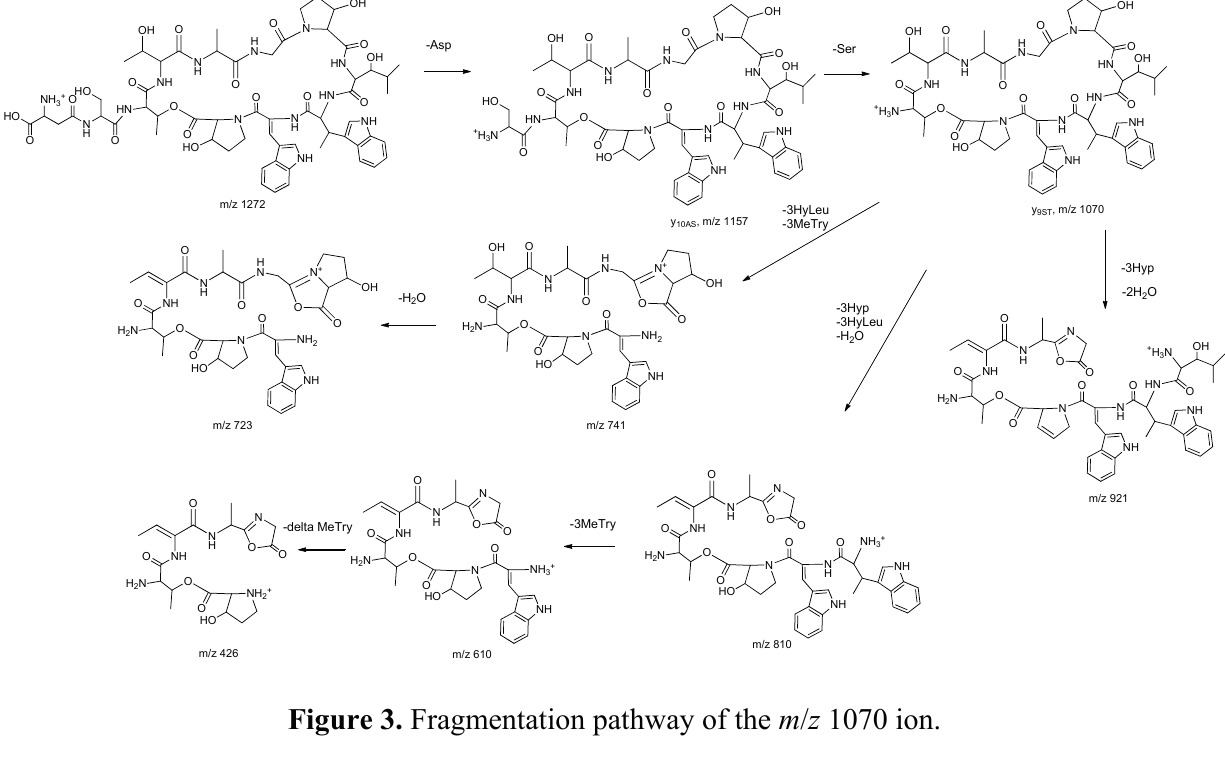
Figure 3. Fragmentation pathway of the m / z 1070 ion.